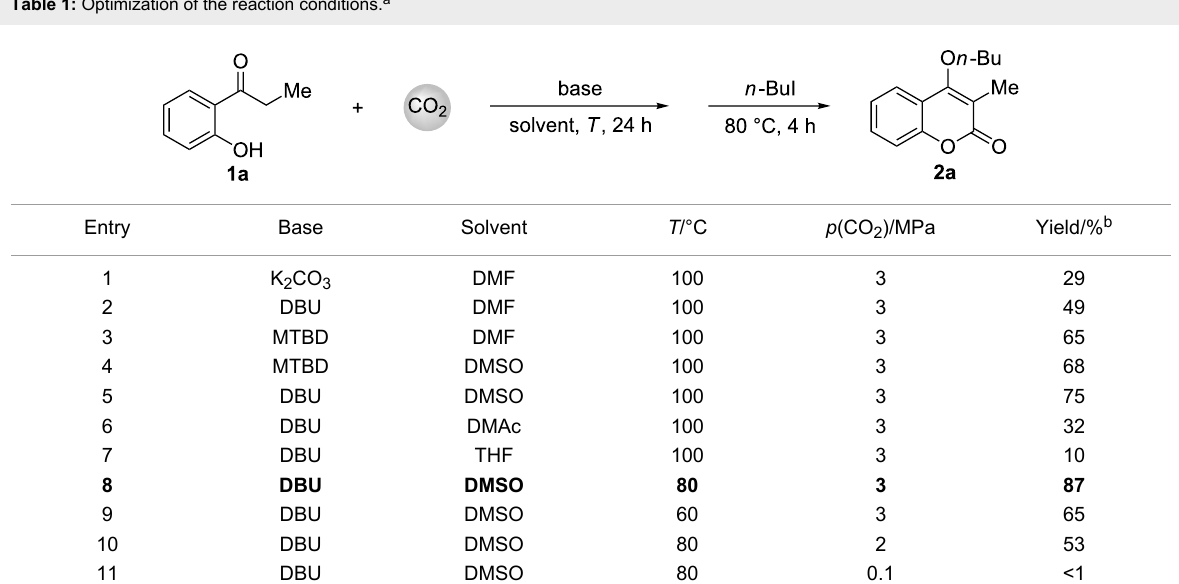
Table 1: Optimization of the reaction conditions.